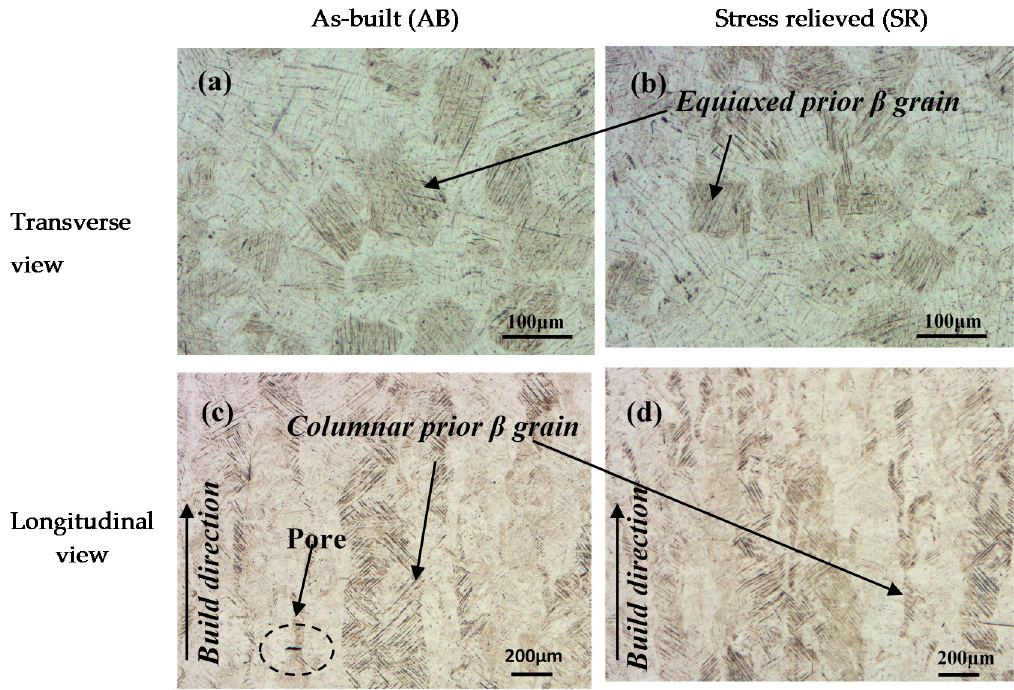
Figure 4. Typical optical micrographs of the as-built (AB) ( a , c ) and stress-relieved (SR) ( b , d ) transverse and longitudinal sections of the specimens in relation to the build direction, respectively.